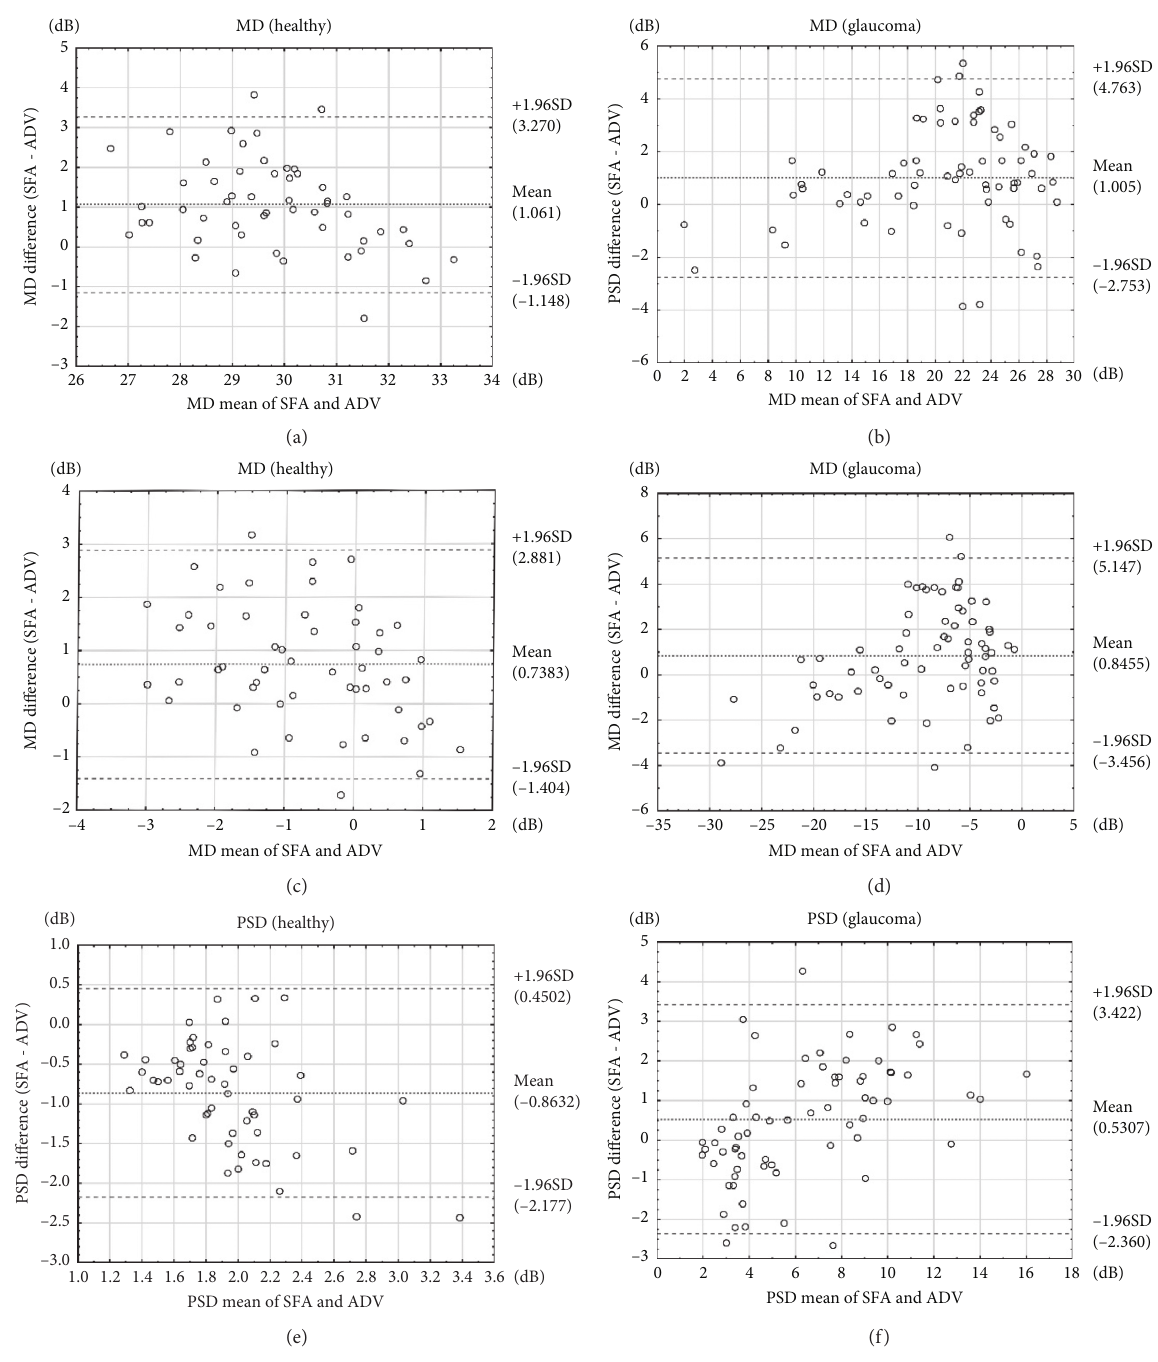
Figure 4: Bland–Altman plots for MS (a, b), MD (c, d), and PSD (e, f). The dashed lines indicate the 95% agreement